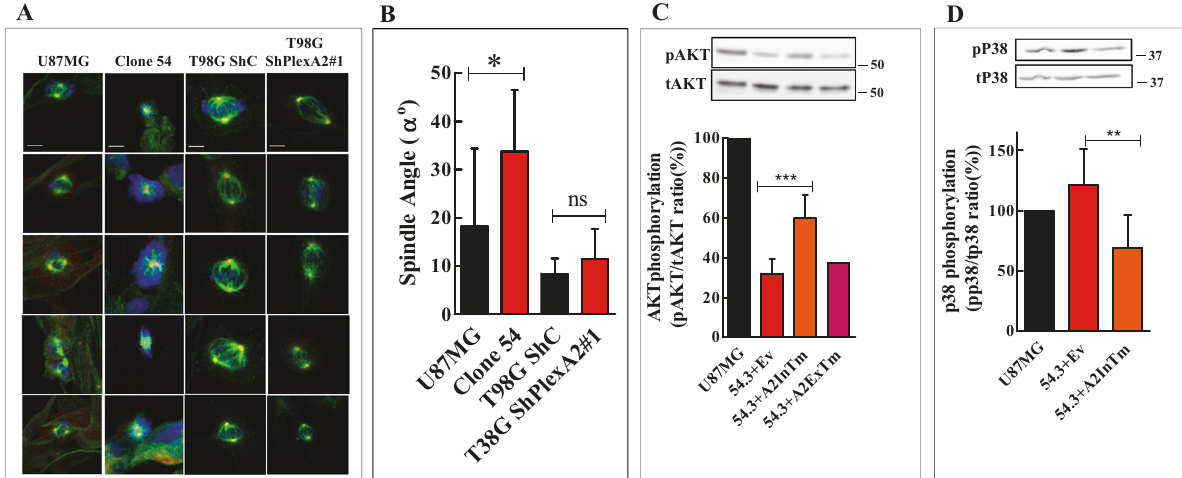
Fig. 6 U87MG cells in which the plexin-A2 gene is knocked-out have abnormal mitotic spindles and display changes in the phosphorylation of AKT and P38. A The indicated cell types were seeded on fi bronectin-coated coverslips and stained with DAPI to visualize cell nuclei (blue) and with antibodies to alpha-tubulin (green) and gamma-tubulin (red). Shown are 3D confocal photographs generated using the Imaris software. Scale bars: 10 μ m. B The X – Z axis stack projections of the photographs generated from laser-scanning confocal images taken